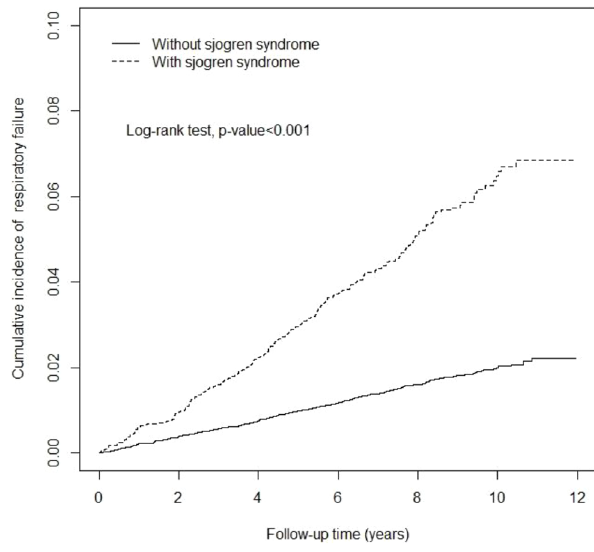
Figure 1. Cumulative incidence curves of respiratory failure for Sjogren syndrome and control